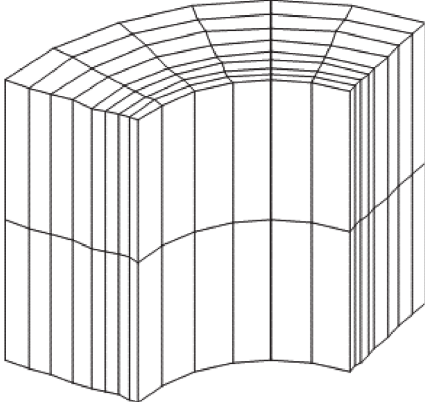
Figure 3: The mesh of numerical example.